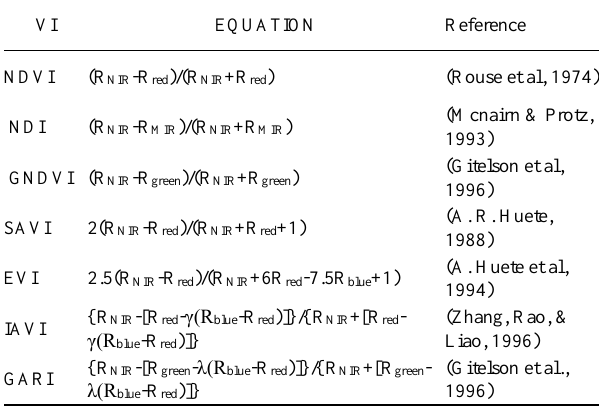
Table 2. observed sugarcane yield(ton/ha)